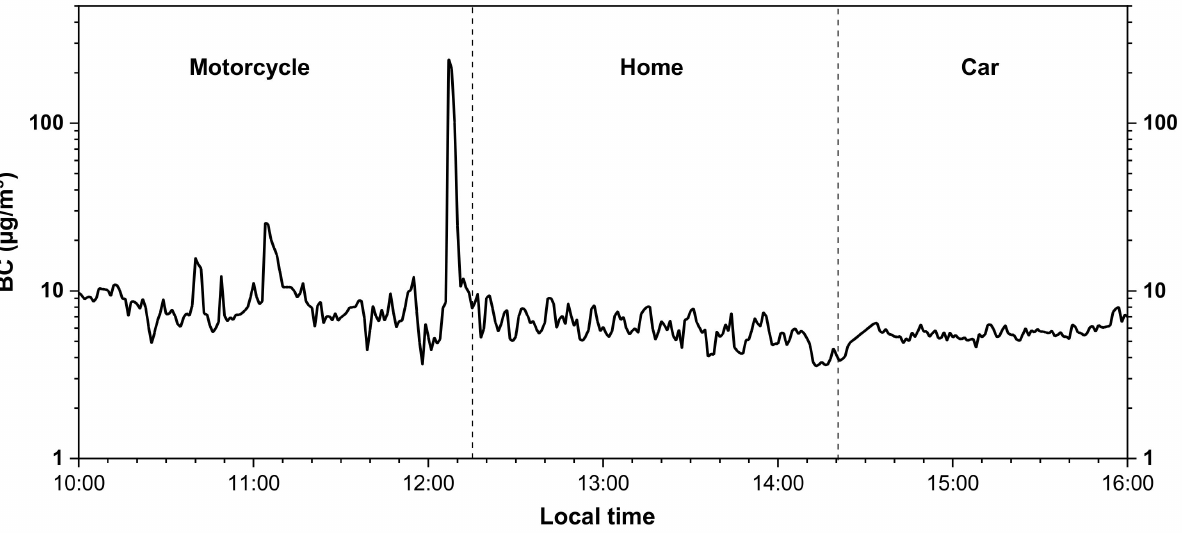
Figure 3. BC exposure for motorcycle, home, and car for the mobile